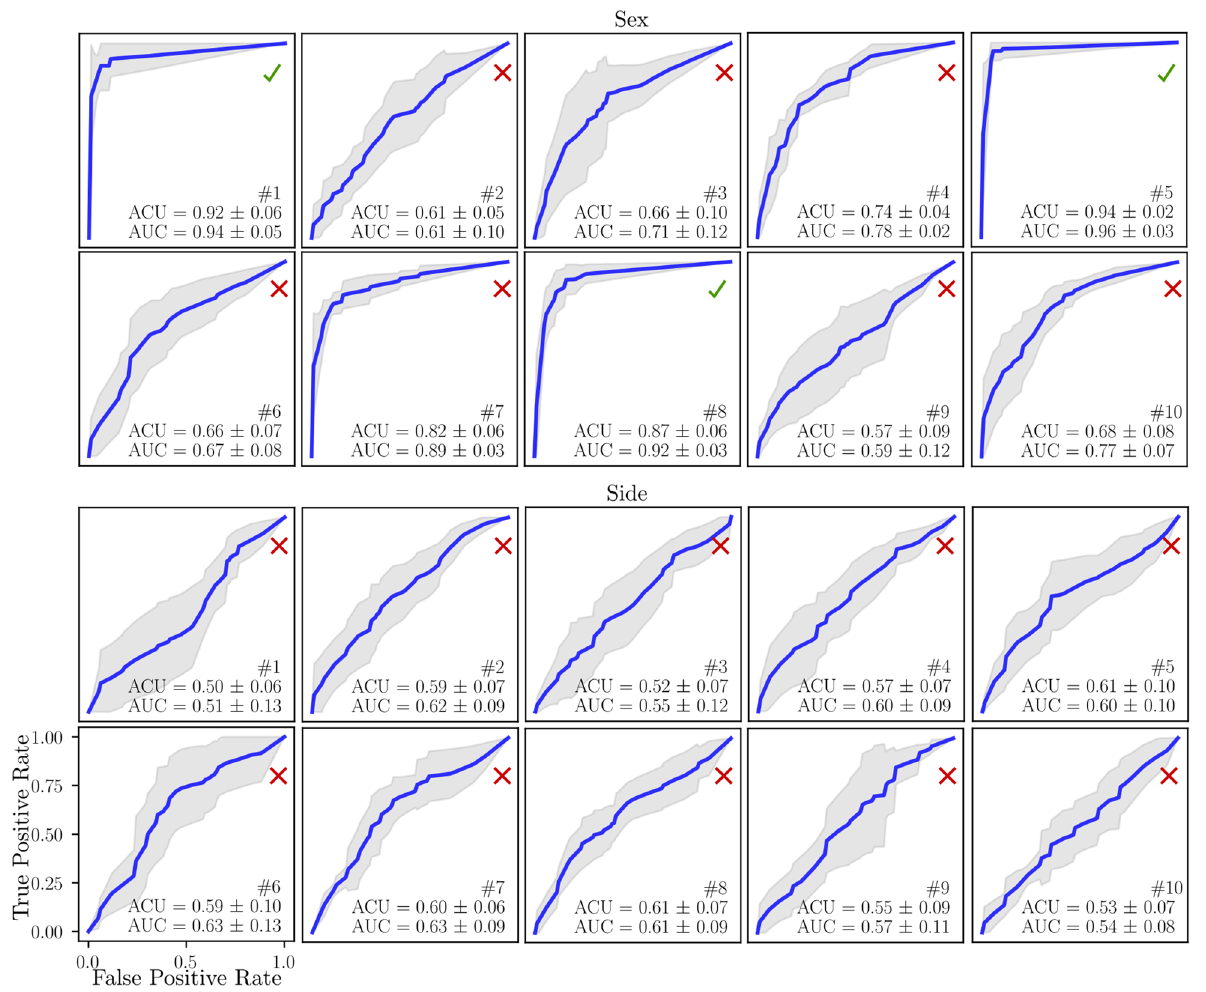
Figure 4. The sex and side classification ability of ten modal stiffnesses for model FEMP-II. The blue curve indicates the mean ROC, while grey fill the standard deviation. The mean ACU/AUC with a standard deviation is computed within cross-validation step.